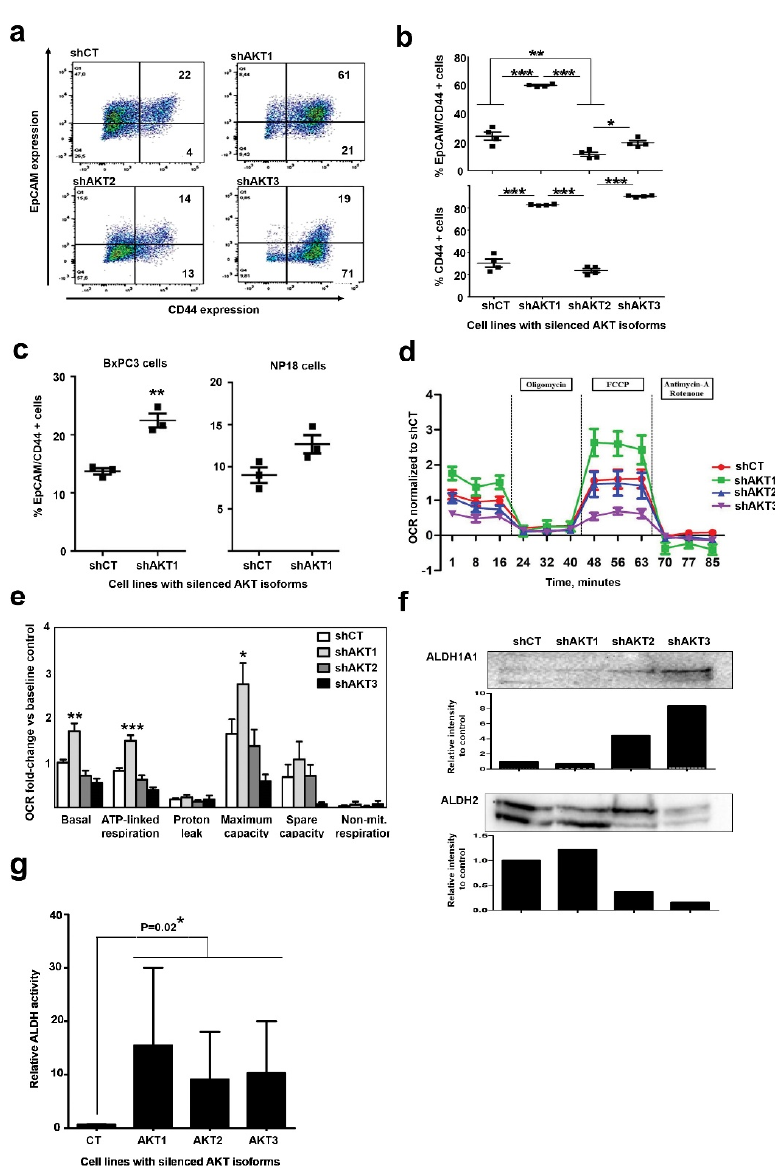
Figure 5. Adapted cells to AKT1 silencing acquire characteristics of cancer stem-like cell. ( a ) Left Flow cytometry density plots of CD44/EpCAM co-expression in the surface of pancreatic cancer cell lines adapted to silencing of the indicated AKT isoform. Percentages of events are shown within each quadrant. ( b ) Scatter plots representing the percentage of cells that co-express CD44/EpCAM (top) or only CD44 (bottom). Data from four biological replicates are shown. Relevant statistical comparisons are shown within the graph, calculated by ANOVA and Tukey´s pairwise tests. ( c ) Scatter plots representing the percentage of cells that co-express CD44/EpCAM for the indicating cell lines. Data from four biological replicates are shown. Relevant statistical comparisons are shown within the graph, calculated by ANOVA and Tukey´s pairwise tests. ( d ) Graph displaying oxygen consumption rates (OCRs) in the indicated cell lines following the addition of oligomycin, FCCP or Antimycin-A/rotenone as shown. Results are shown as means from three technical replicates, together with error bars (SD). ( e ) Bar graph displaying oxygen consumption rate (OCR) for each indicated cell line quantified by Seahorse XF and normalized to baseline OCR from control cells following the addition of the indicated compounds. Data are shown as means and error bars OCR attributed to each mitochondrial function calculated from (C top), and data shown as means and error bars . ( f )